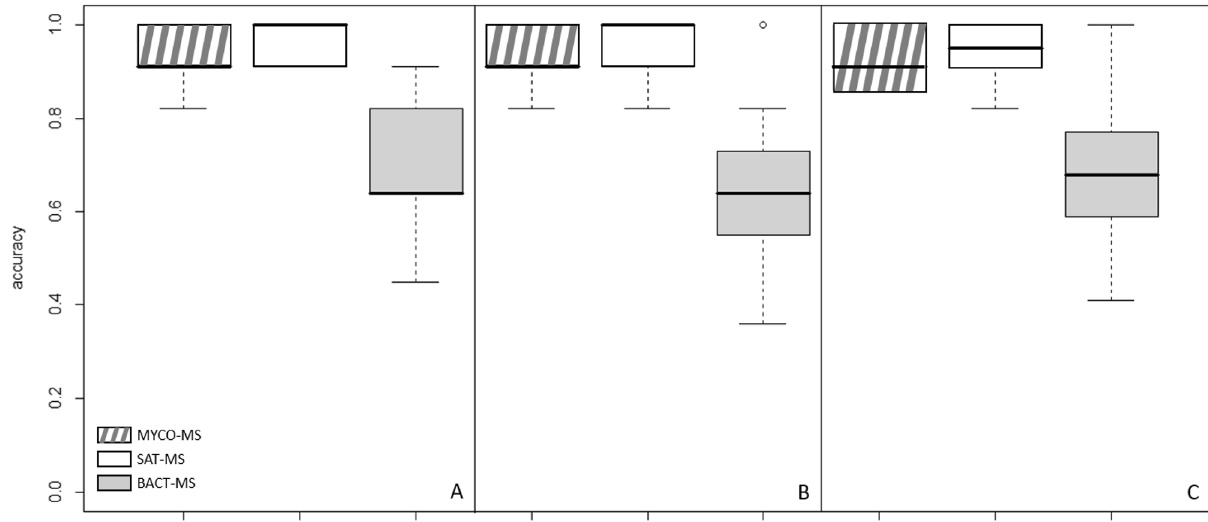
Figure 5. Classification capacity of the CNN model for the three different mass spectrometers. Classification results with test spectra from Day-3 ( A ), Day-5 ( B ) of growth, and global assessment using both spectra from Day-3 and Day-5 ( C